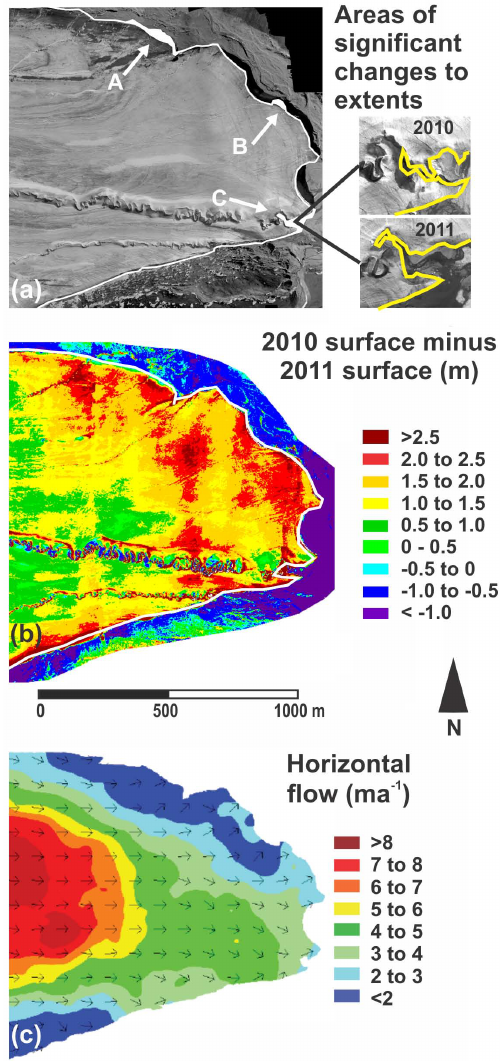
Fig. 3. (a) Changes in glacier margins from 2010 to 2011 (inset shows detail of changes around the exit point of the supraglacial stream). Areas where significant changes have occurred are shown in white and denoted by A, B and C; (b) change in ice thickness measured from 1 July 2010 to 2 July 2011. Increases in thickness to the east of the terminus reflect changes to the proglacial icing; (c) horizontal flow speed and flow direction between 1 July 2010 and 2 July